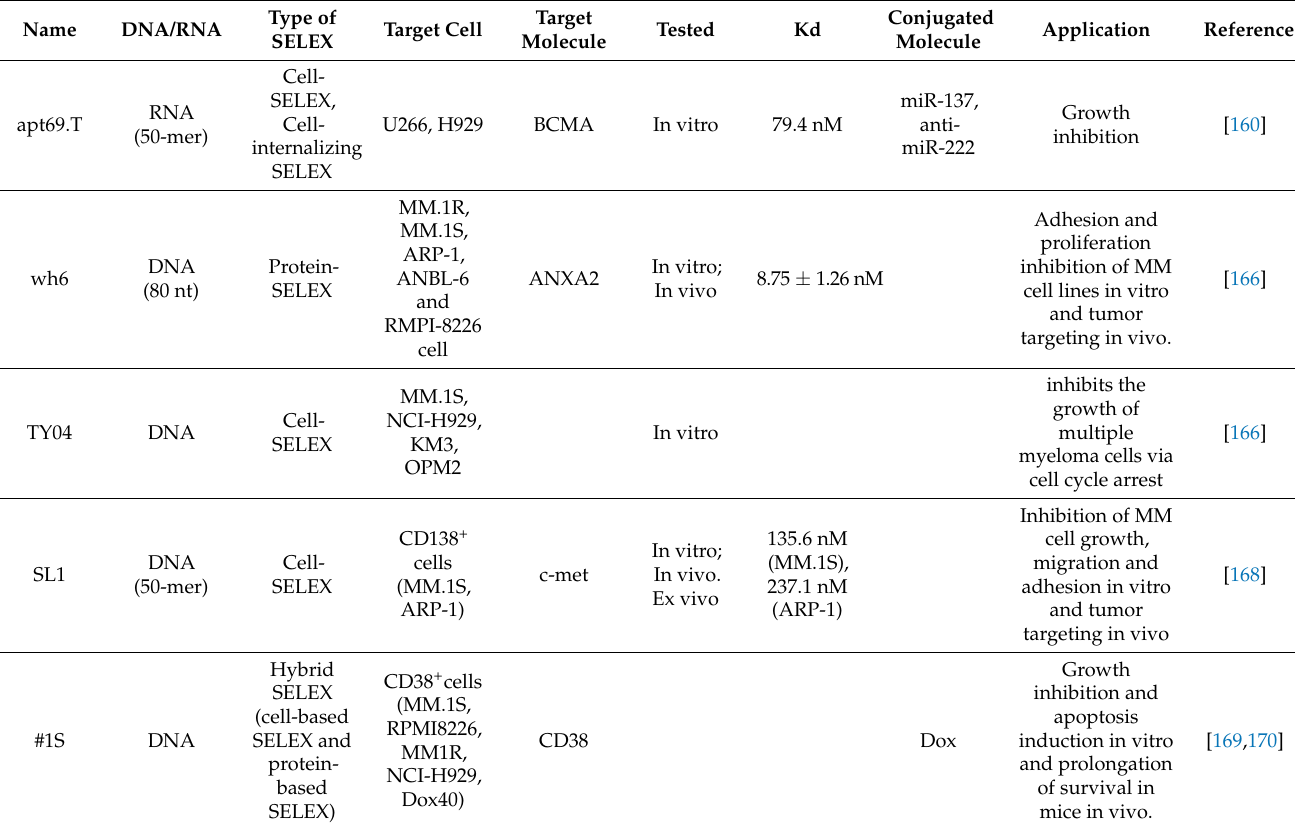
Table 4. A summary of aptamers that have been identified to MM. Kd = dissociation